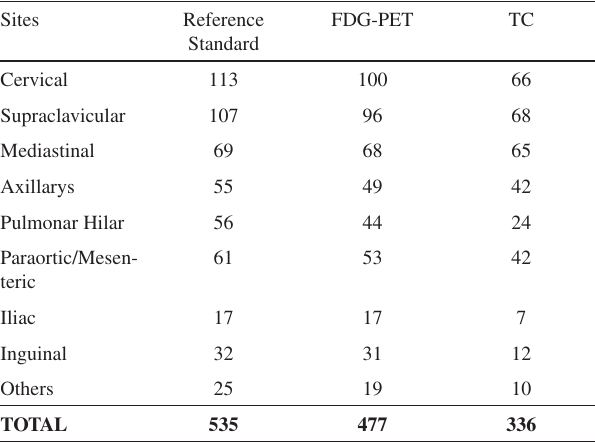
Table 2 - Region-based analysis of lymph nodes sites using CT and FDG-PET in 82 patients during the initial staging Sites